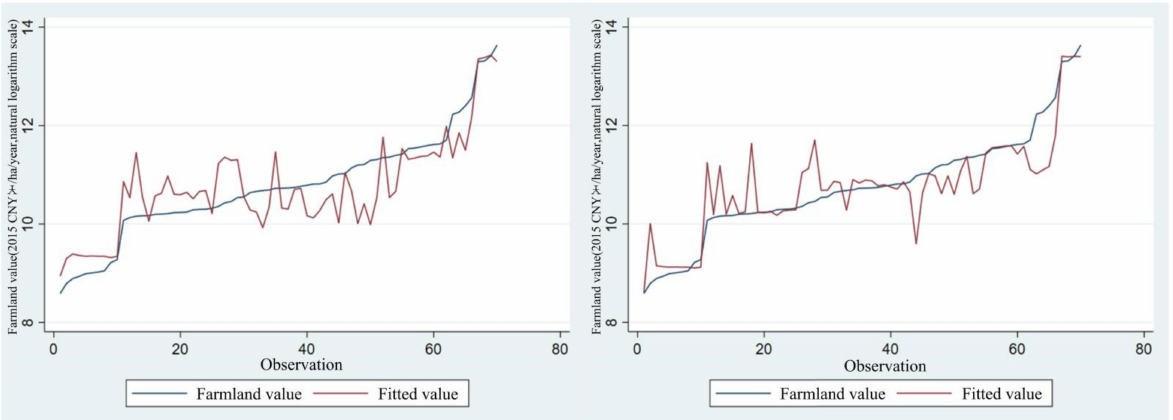
Figure 3. Value observations and predicted value (value observations are sorted in ascending order, with Model (D) on the left and Model (E) on the